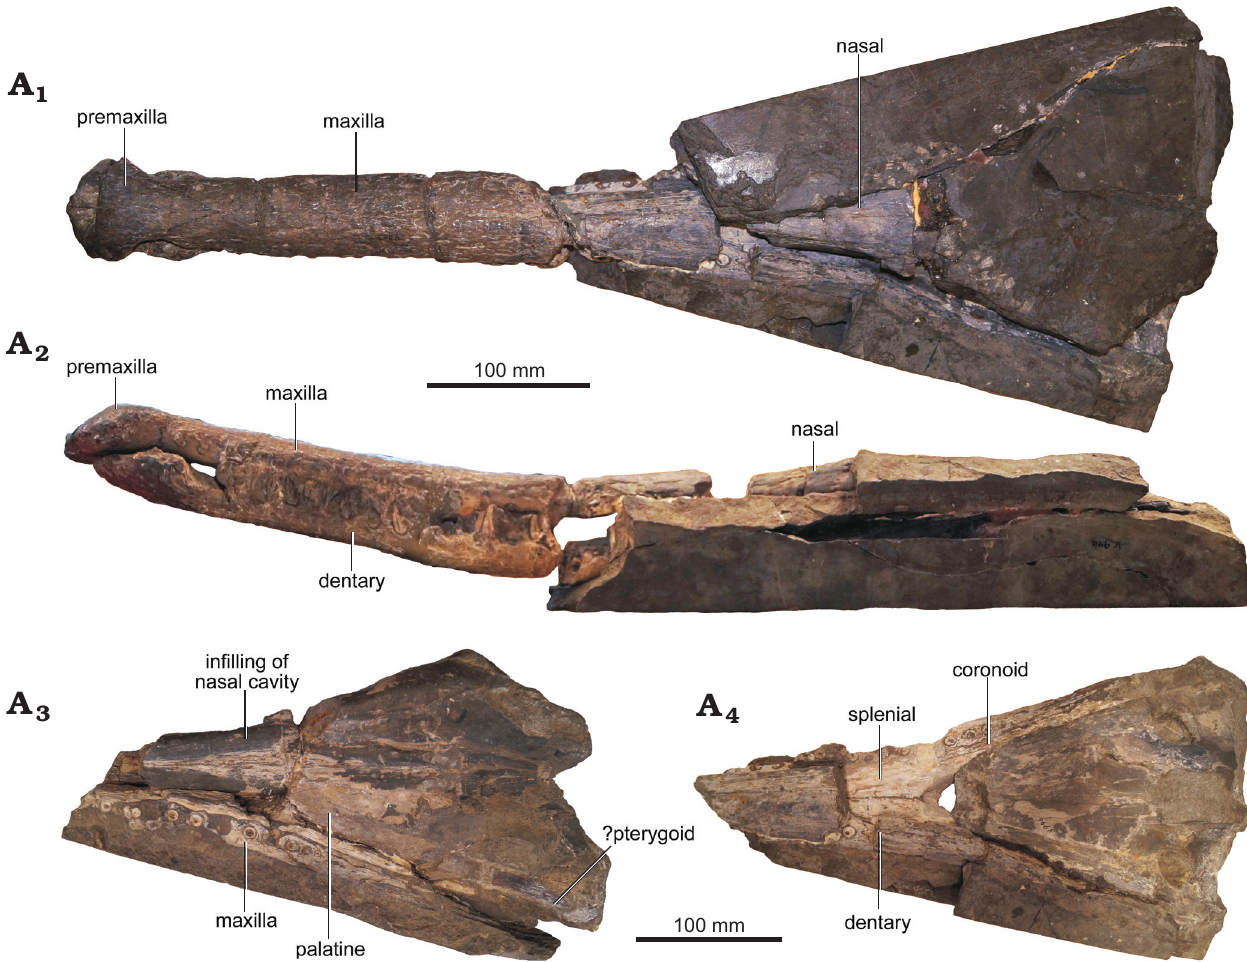
Fig. 1. Teleosauroid thalattosuchian Mystriosaurus laurillardi Kaup, 1834 (HLMD V946-948, holotype), lower Toarcian of Altdorf (southern Germany); skull in dorsal (A 1 ) and lateral (A 2 ) views, midsection of the skull in ventral view (A 3 ), and of the mandible in dorsal view (A 4